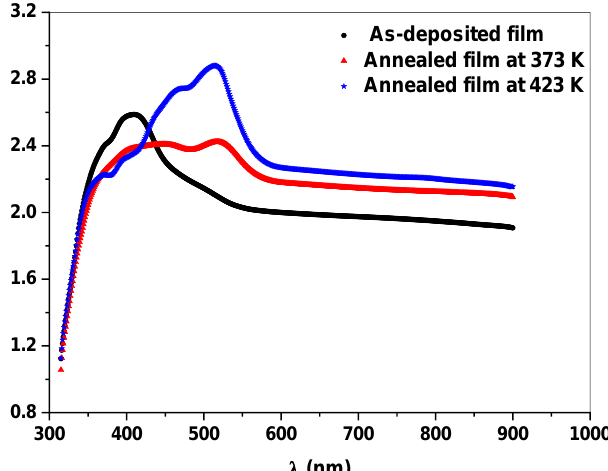
Figure 16. The spectral dependence of the real part of the refractive index of compound 4 thin films.